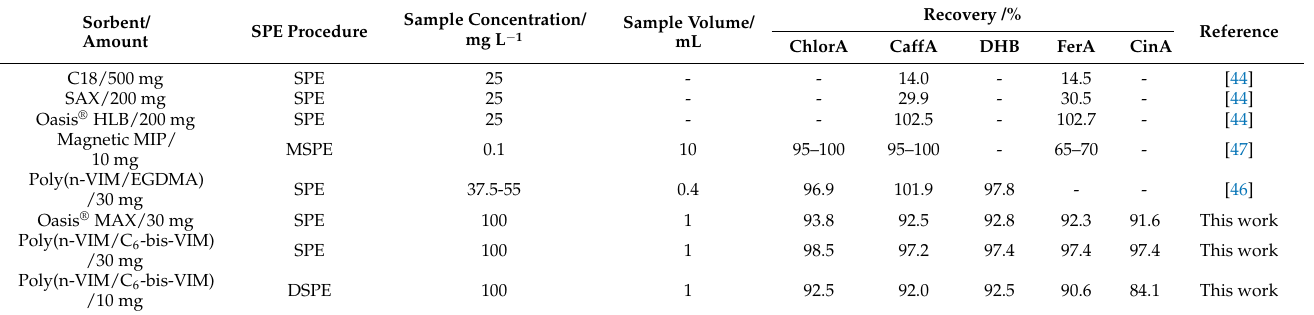
Table 3. Comparison of the developed DSPE and adapted SPE procedure with other solid-phase extraction methods for phenolic